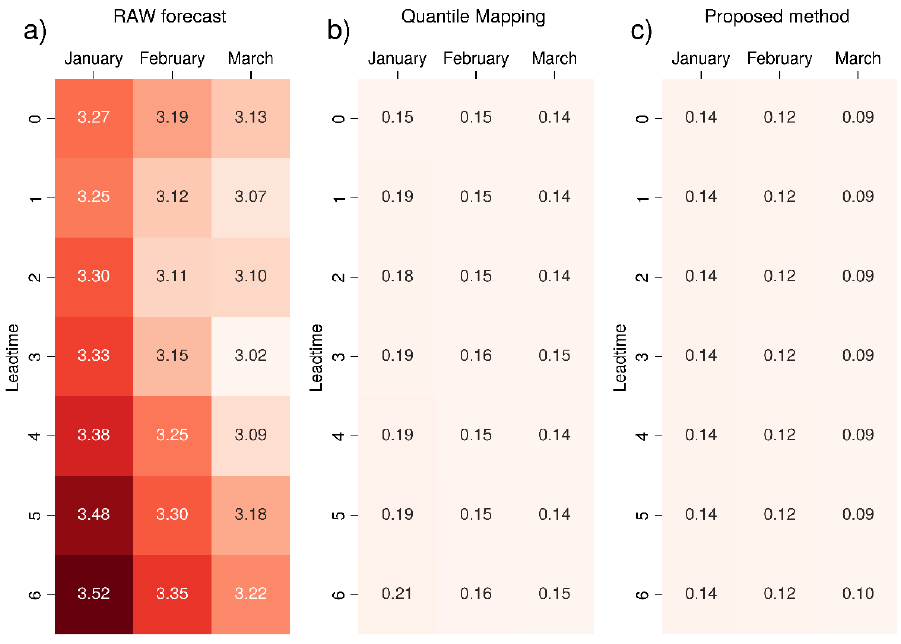
Figure 3. RMSE (in K) of the 2 m mean temperature 99th percentile value for seasonal forecast System 7 (M é t é o-France) compared to ERA5 reanalysis: ( a ) raw data, ( b ) data corrected with standard quantile mapping and ( c ) corrected with the proposed bias correction method. The colour scale ranges from white (RMSE = 0) to dark red, increasing in intensity as the metric increases. The most intense colour corresponds to the maximum